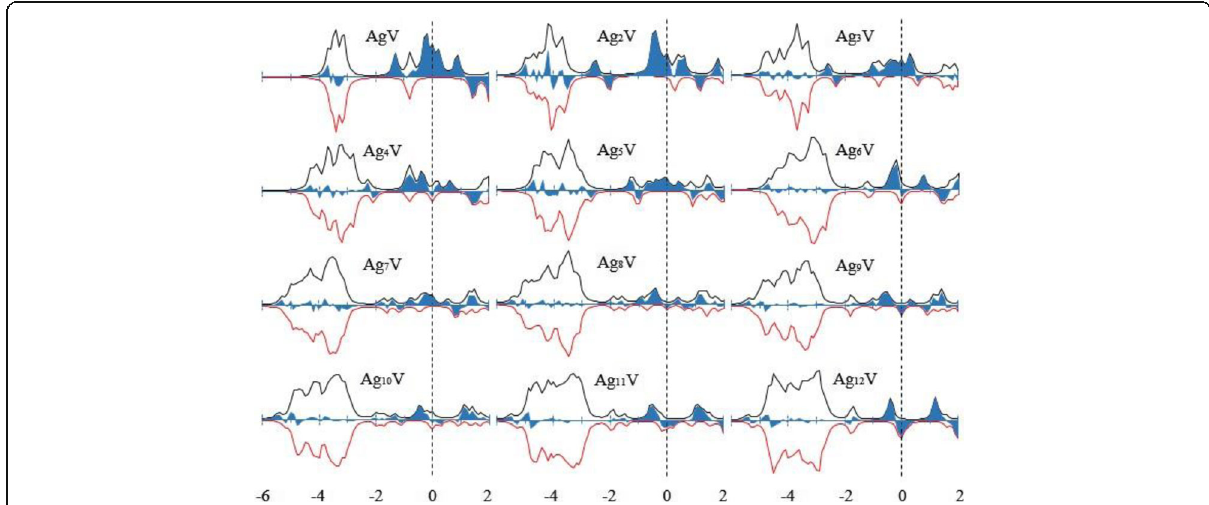
Fig. 8 The SDOS of ground state Ag n V ( n = 1 – 12) clusters. Spin up is positive and spin down is negative. A broadening factor δ = 0.1 eV is used. Spin up minus spin down is the blue part. The dashed line indicates the location of the HOMO